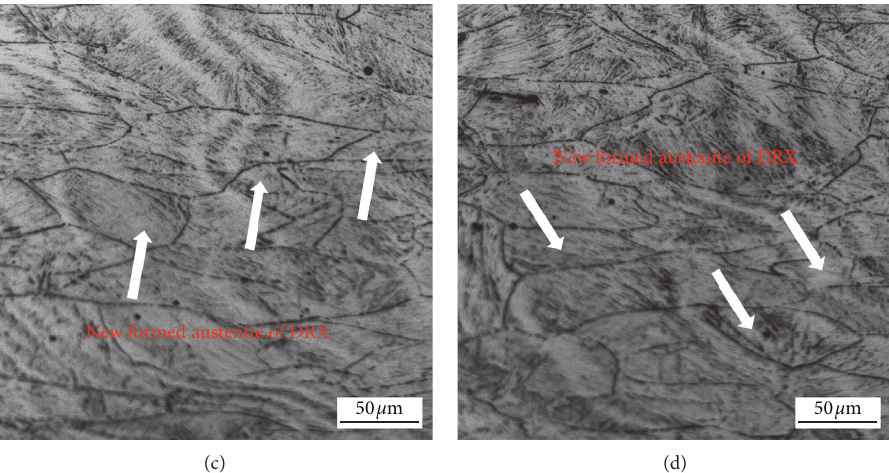
Figure 5: Austenite grain metallography of undeformed (a) strain rate 0.5s − 1 at 1050 ° C, (b) strain rate 0.1 s − 1 at 1050 ° C, and (c) strain rate 0.01s − 1 at 1050 °